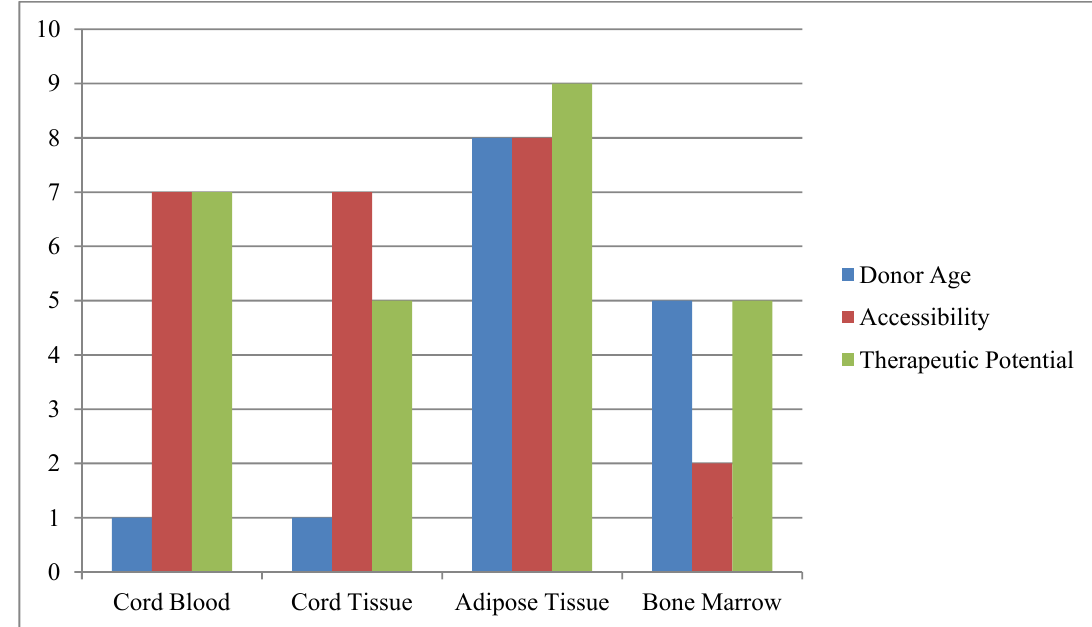
Cord Blood Cord Tissue Adipose Tissue Bone Marrow